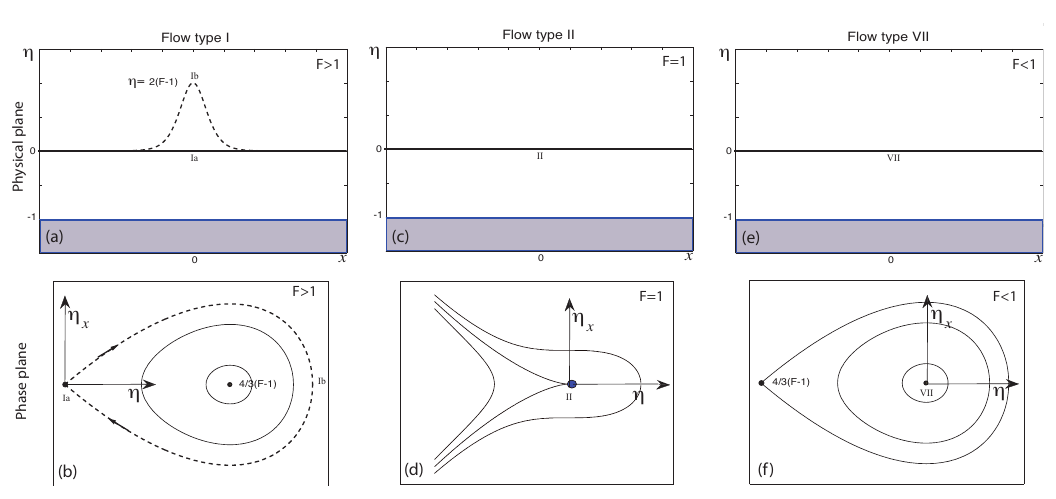
Figure 3. The unforced flow problem [27,61,62,73]. ( a , b ) Supercritical flow type I with F > 1. Solution sub-type Ia is a uniform stream, solid line in ( a ) and saddle point in ( b ). Solution sub-type Ib is the well-known unforced solitary wave, broken curves in ( a , b ). ( c , d ) Critical flow type II, with F = 1, is a uniform stream, solid line in ( c ) and degenerate node in ( d ). ( e , f ) Subcritical flow type VI, with F < 1, is a uniform stream, solid line in ( e ) and centre in ( f